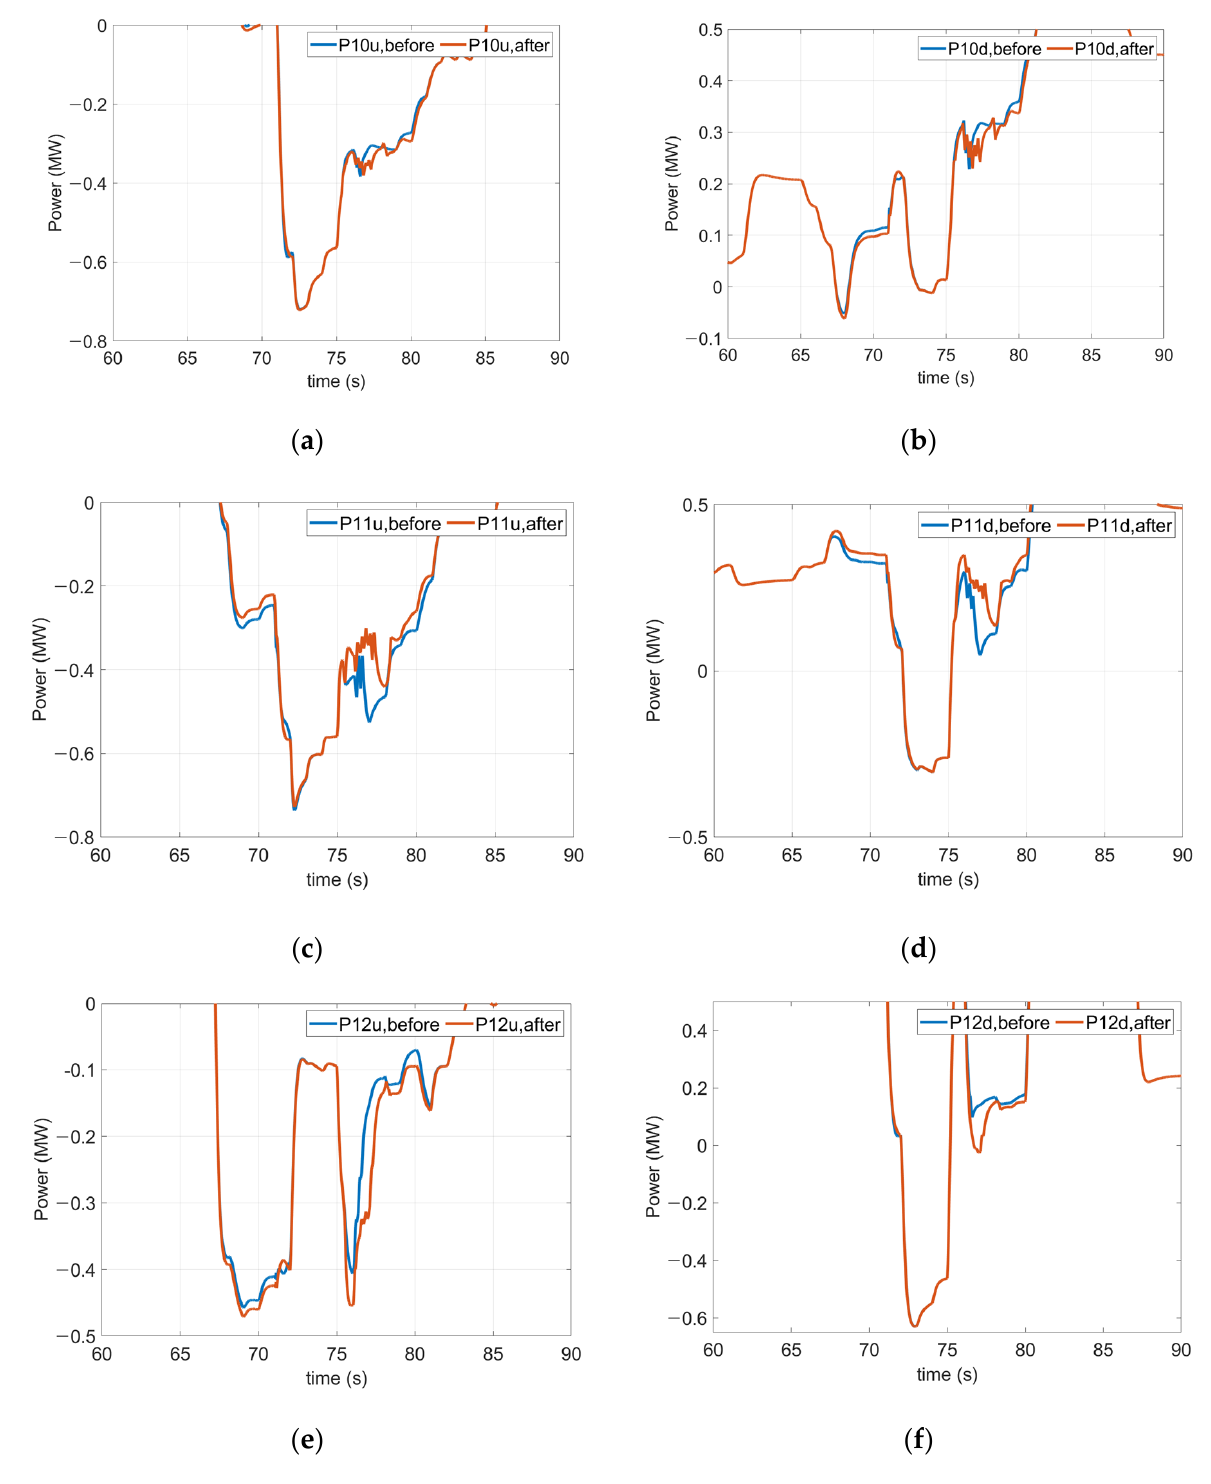
Figure 12. Power consumption of substations ( a ) 10 up ( b ) 10 down, ( c ) 11 up ( d ) 11 down, ( e ) 12 up ( f ) 12 down.